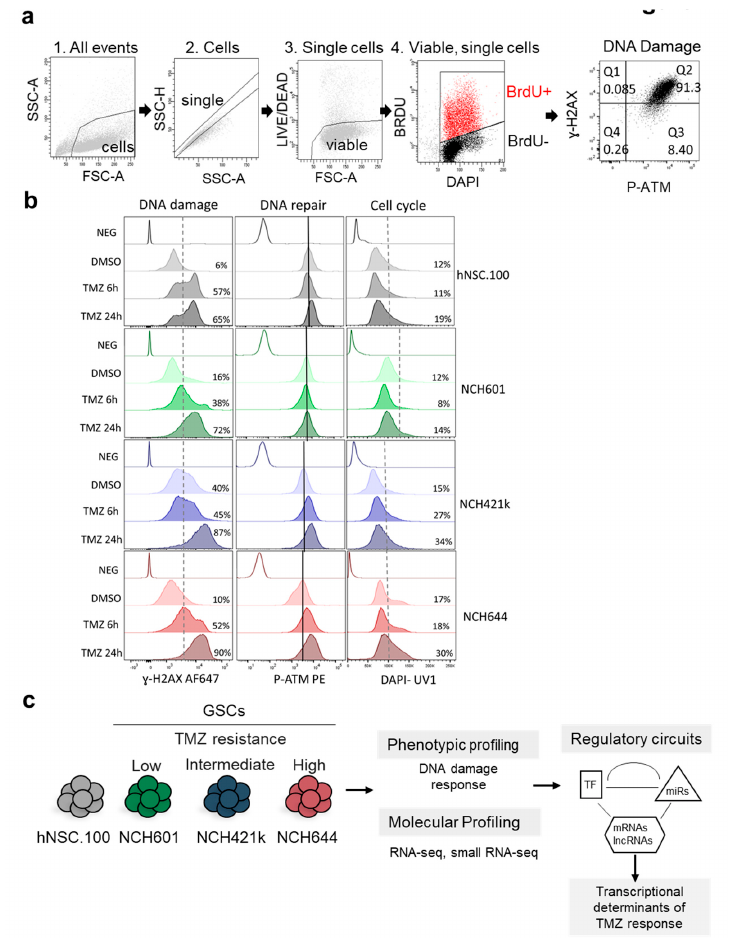
Figure 1. Glioblastoma (GBM) cells differentially activate DDR (DNA damage Response) in response to TMZ (temozolomide). ( a ) Gating strategy used for flow cytometry analysis. NCH644 GSCs (Glioblastoma stem-like cells) after 24 h TMZ treatment are shown as an example. (1) Cells were distinguished from debris using Forward Scatter (FSC) and Side Scatter (SSC). (2) Cell doublets and aggregates were gated out based on their properties displayed on the SSC area (SSC-A) versus height (SSC-H) dot plot. (3) Dead cells were recognized by their strong positivity for the dead cell discrimination marker. (4) Proliferating cells were distinguished as BRDU+ (Bromodeoxyuridine / 5- bromo-2'-deoxyuridine) events. DAPI (4 ′ ,6-diamidino-2-phenylindole)staining shows cell cycle profile. (5) DNA damage was assessed by measuring the levels of ɣ -H2AX whereas P-ATM (phosphorylated Ataxia telangiectasia mutated) was used to measure the extent of DDR activation. The gating applied discriminates between P-ATM positive vs. negative cells, and ɣ -H2AX high vs. low cells. Percentage of cells in each quartile is presented. ( b ) Response to TMZ was analyzed in GSCs (NCH601, NCH421k, and NCH644). Neural stem cells (hNSC.100) were used as a non-neoplastic control. DNA damage ( ɣ -H2AX), DNA repair (P-ATM), and cell cycle profiles (DAPI) after TMZ treatment (TMZ 6 h and TMZ 24 h) or DMSO as vehicle, are measured in the indicated cell lines. Isotype controls for antibody staining are shown for each cell (Neg). Dotted lines separate low and high G -H2AX cells, or G0 / G1 and S / G2 / M cell cycle (DAPI graphs). Percentage of G -H2AX high cells and cells in the S / G2 / M cell cycle phases is presented. Black lines indicate median expression of P-ATM in DMSO treated cells. ( c ) GBM stem-like cells of di ff erent chemoresistance to TMZ: Low (NCH601), Intermediate (NCH421k), and High (NCH644), and neural stem cells (hNSC.100) were further used for transcriptional profiling and systems level